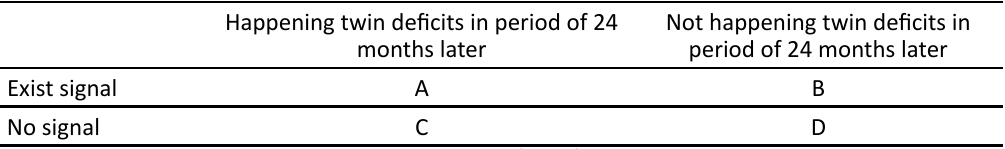
Table 3: Signal Matrix of Twin Deficits